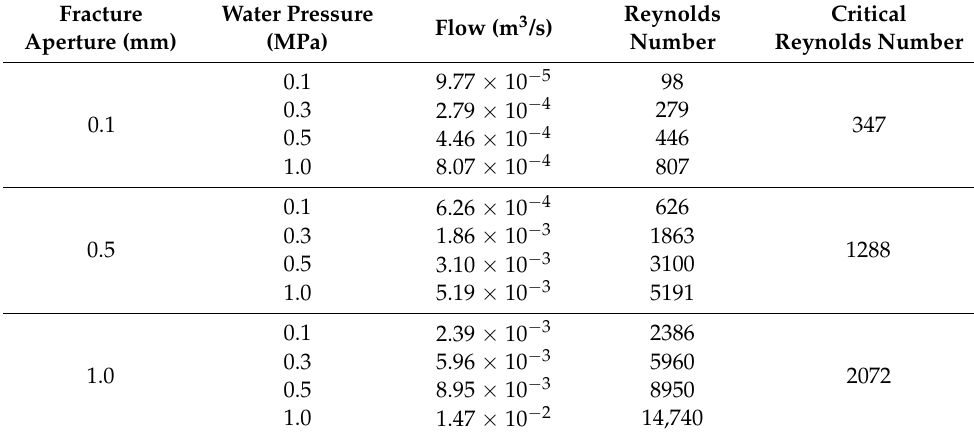
Table 9. Parameter values and calculation results of